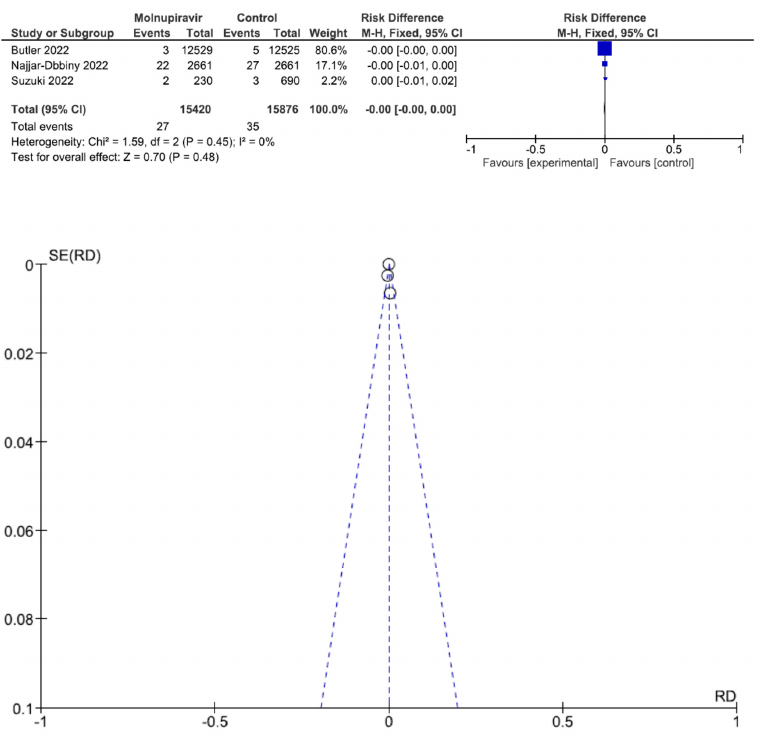
Figure 4. All-cause mortality between molnupiravir and placebo in the treatment of mild to moderate COVID-19 in adult patients with high COVID-19 vaccination coverage [26,28,29]. Two studies involving 57,929 patients with low COVID-19 vaccination coverage (6839 who received molnupiravir therapy, 51,090 who received placebo therapy) reported all-cause mortality [30,31]. All-cause mortality was significantly different between mol- nupiravir-treated and placebo-treated patients (RR = 0.62, 95% CI = 0.42–0.93, p = 0.02, I 2 = 88%) (Figure 5).